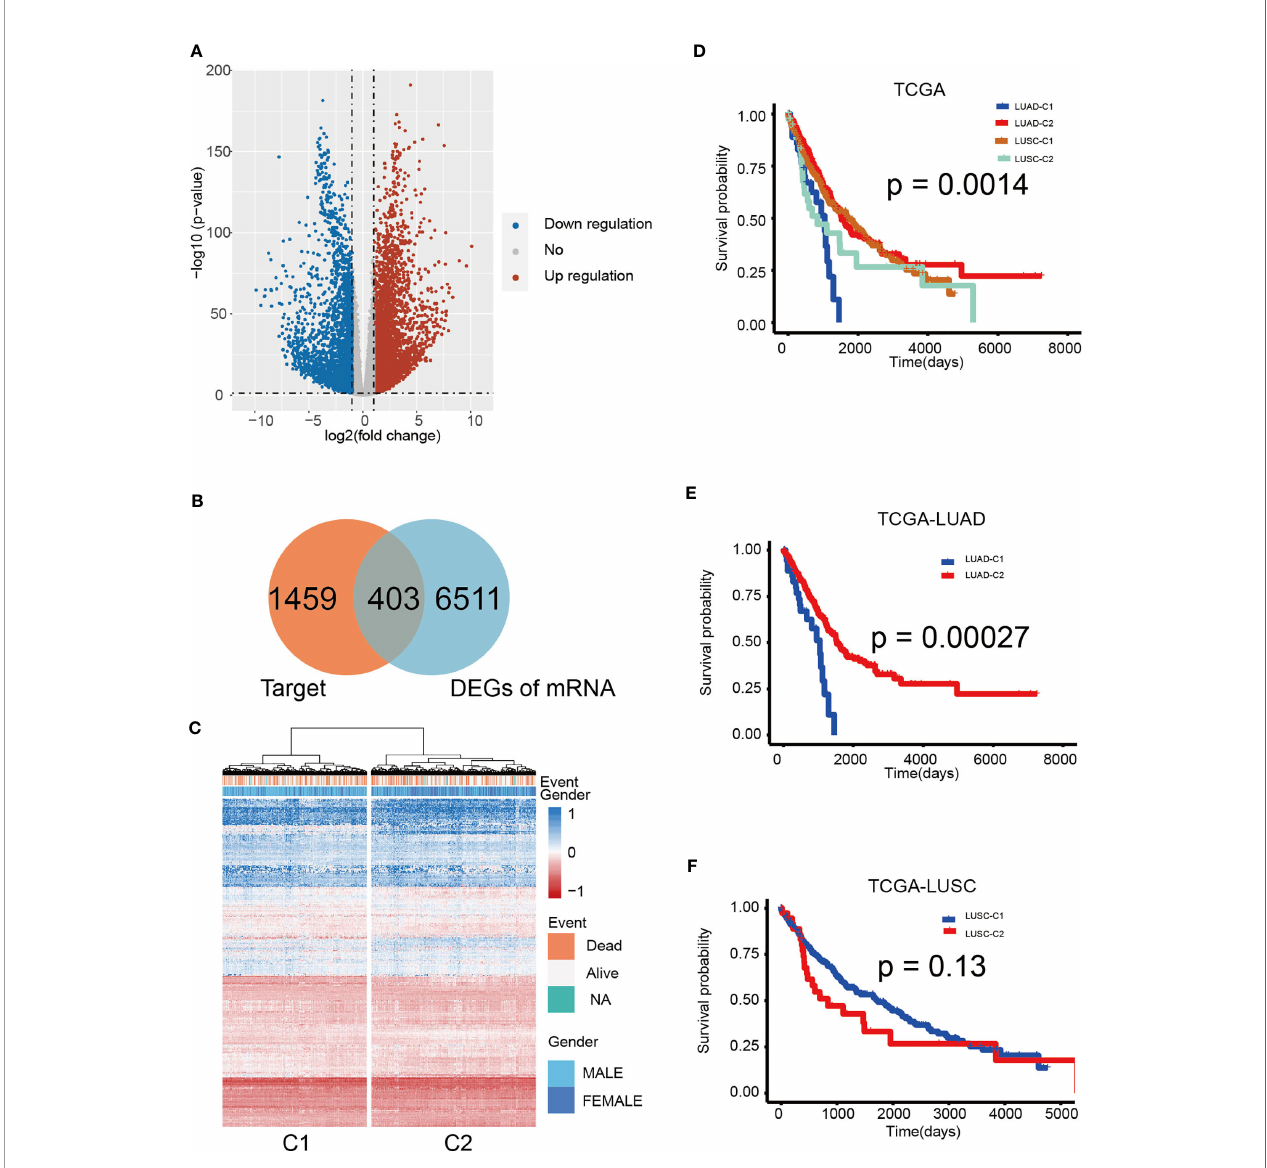
FIGURE 6 | Hierarchical clustering determined distinct sub-clusters linked to variable prognosis based on miRNA targets. (A) Volcano plot of 403 identi fi ed differential expression miRNAs. Cutoffs were set as log2(fold-change) > 1.0 or < – 1.0 and p-value < 0.05. (B) Venn diagram shows that the 403 genes are targets and differentially expressed. (C) Hierarchical clustering of 1,014 patients from the TCGA cohort using 10 miRNAs and 403 gene expressions. (D) Kaplan – Meier curves for cancer-speci fi c survival according to cluster sub-classes. (E) Kaplan-Meier analysis of overall survival based on TCGA-LUAD. (F) Kaplan-Meier analysis of overall survival according to TCGA-LUSC. The log-rank test was used to perform statistical